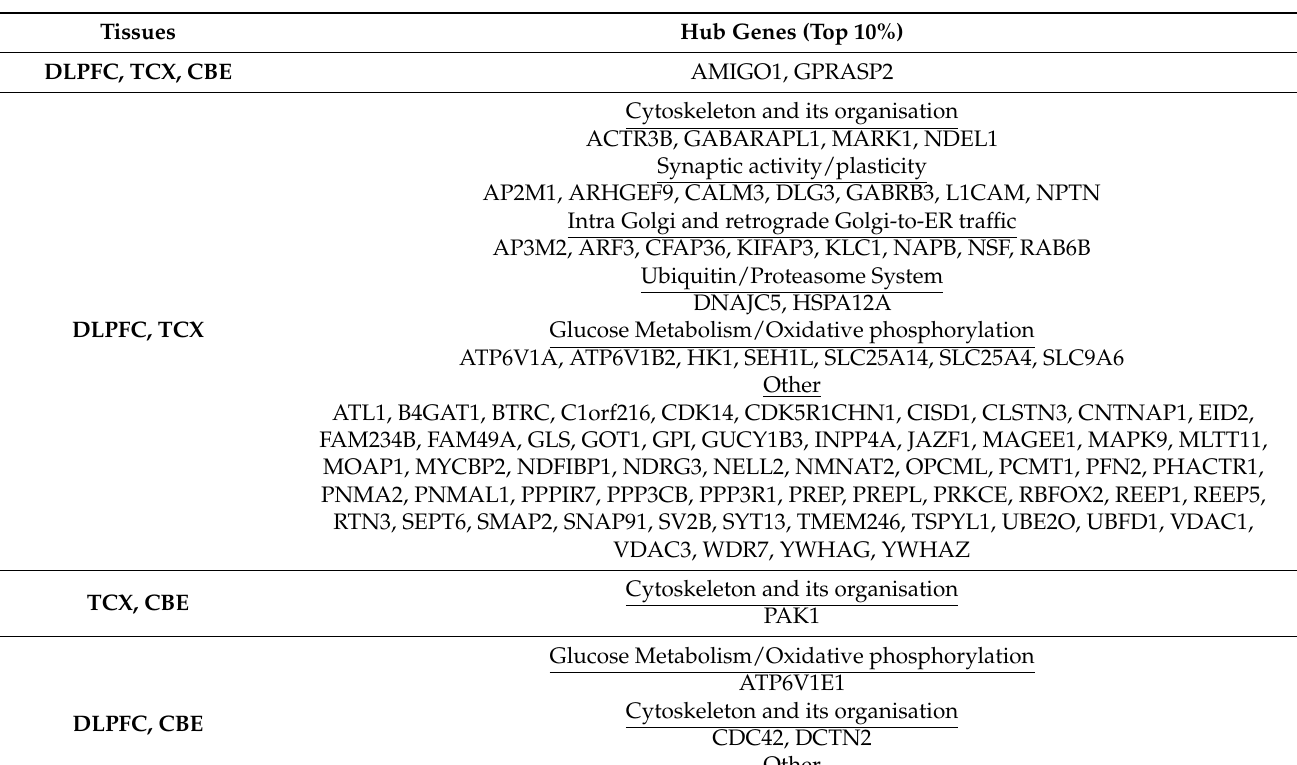
Table 4. Hub genes shared by modules from different tissues and most associated